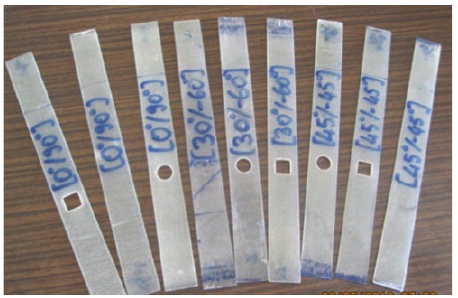
Figure 4 Experimental setup. (1) Data acquisition card, (2) computer, (3)